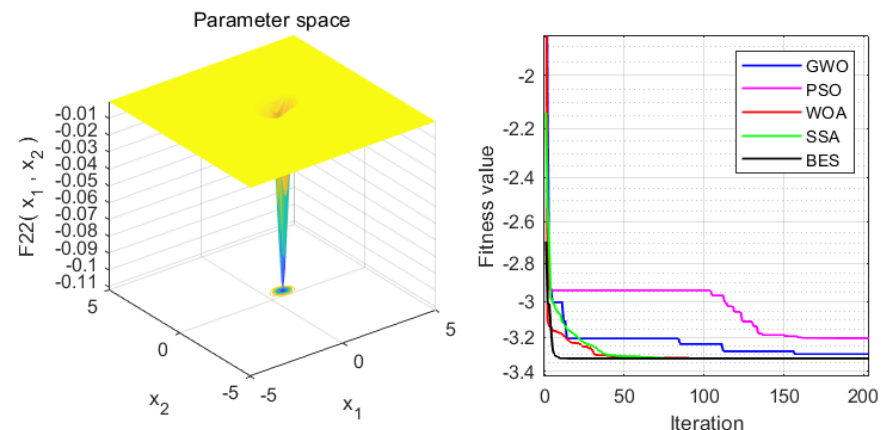
Figure 5. The result of F3.